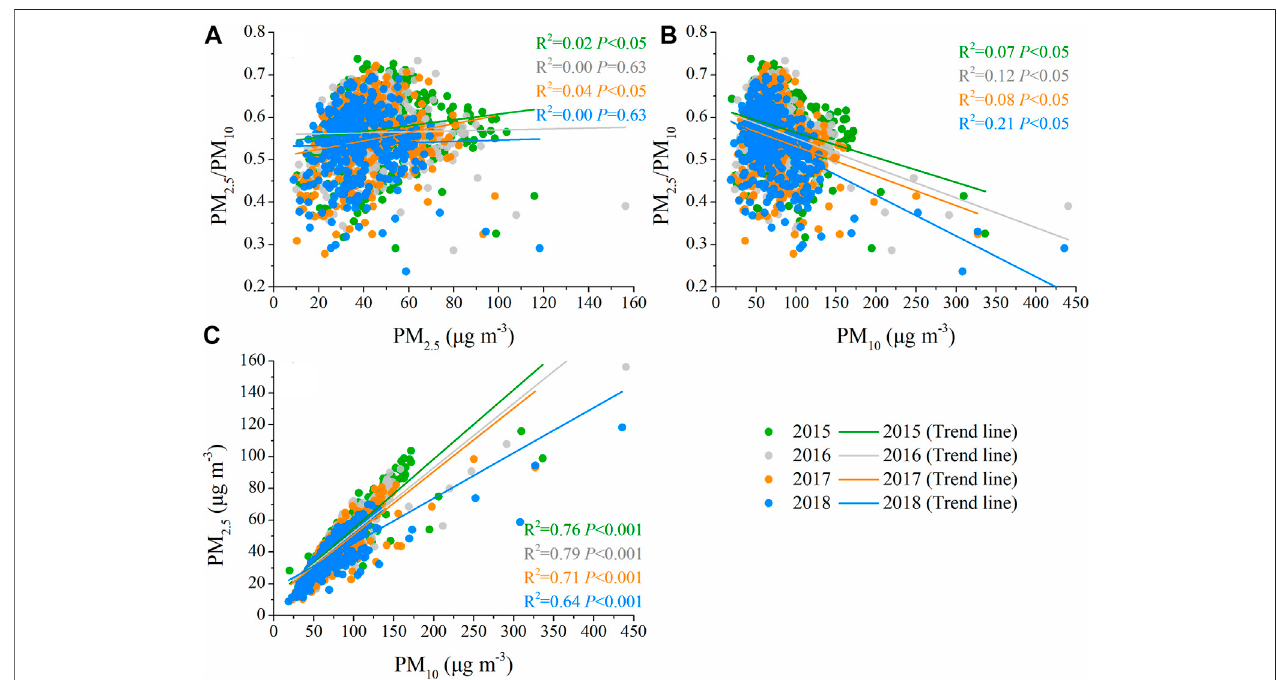
FIGURE 8 | The scattered plots among the PM 2.5 , PM 10 and PM 2.5 /PM 10 ratios obtained from all national ground sites during the study period. The green, gray, orange and blue colors are for data in year 2015, 2016, 2017 and 2018, respectively. (A – C) represent the correlation between PM 2.5 /PM 10 and PM 2.5 , PM 2.5 /PM 10 and PM 10 , and PM 2.5 and PM 10 ,